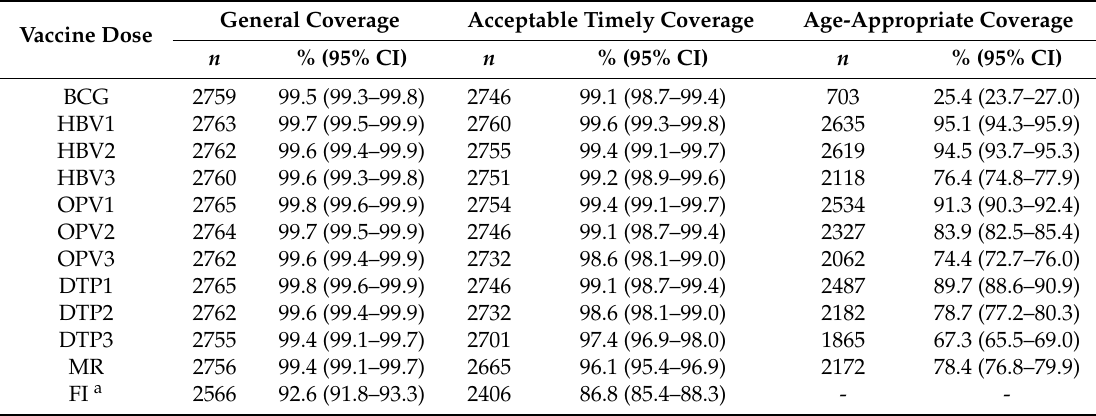
Table 2. Immunization coverage in general, according to acceptable timing, at the appropriate age among children aged 24–36 months, in Zhejiang province ( N =